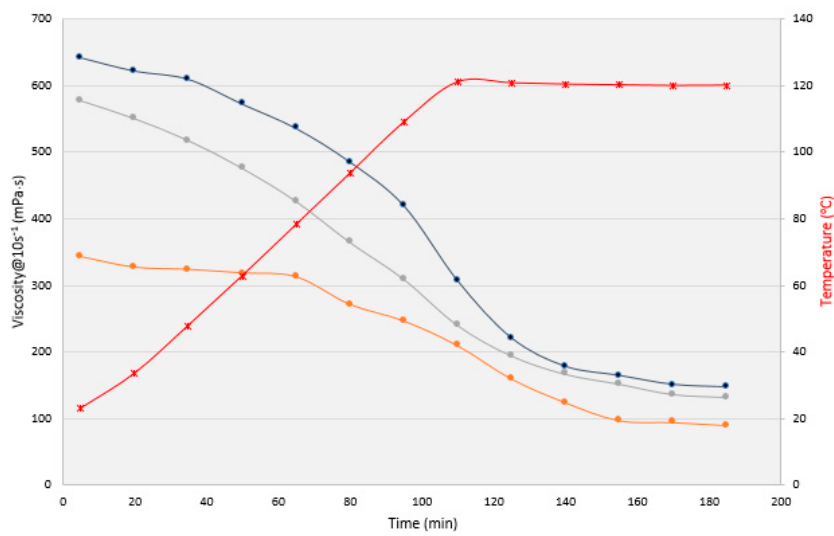
Figure 3. Rheological data of enhanced oil recovery (EOR) fluids.